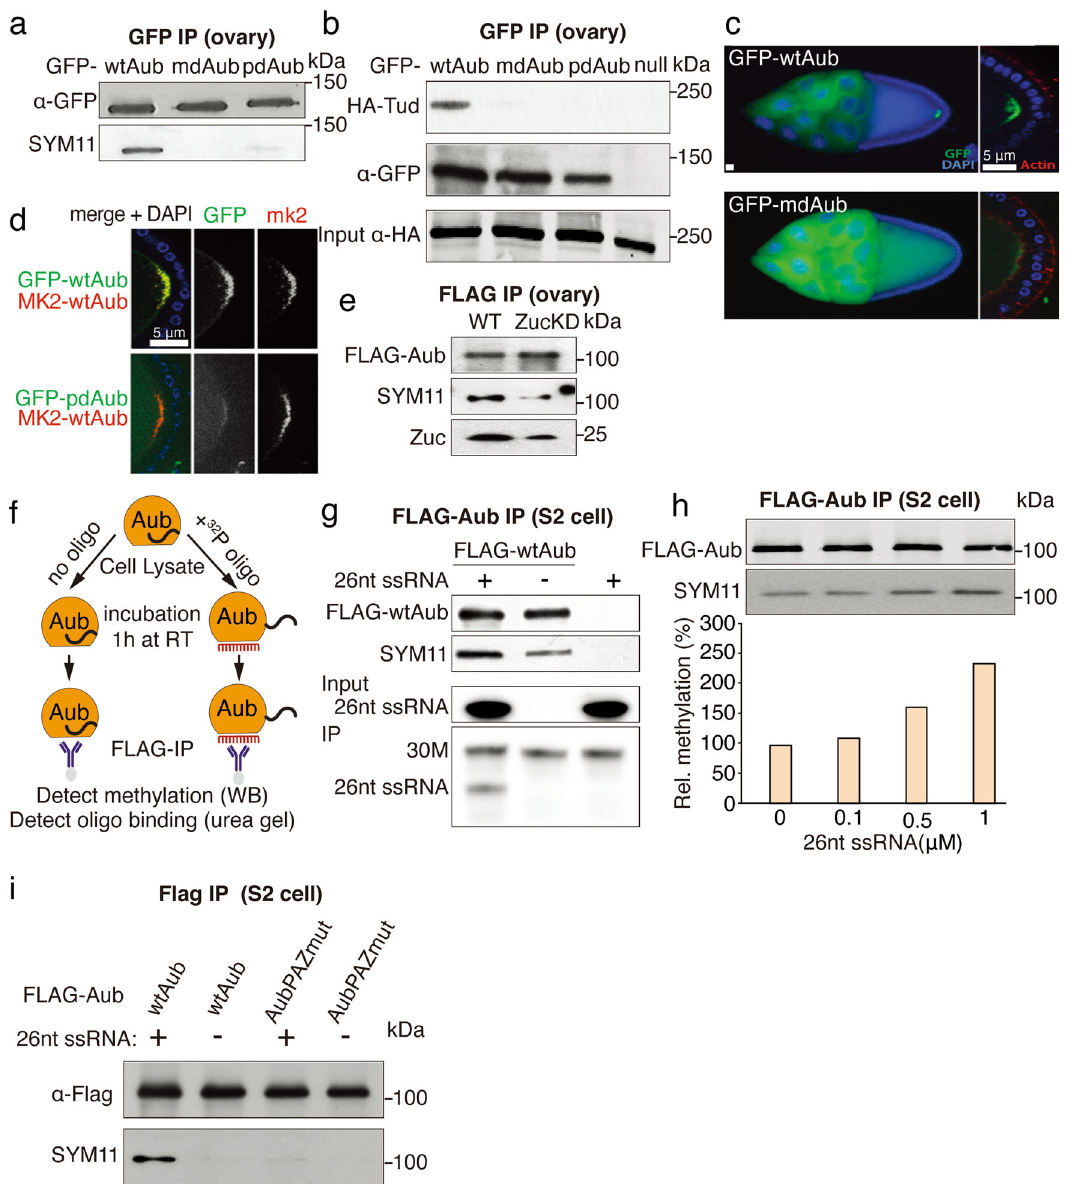
Fig. 5 RNA binding promotes Aub arginine methylation. a RNA binding is required for Aub arginine methylation in vivo. Transgenes were expressed on the wildtype background. Total protein level and methylation was detected in Western blot. The experiment reproduced three times with similar results. b RNA binding is required for Aub interaction with Tudor in vivo. GFP tagged Aub was immunoprecipitated from ovarian lysate, followed by Western blot detection of the tagged transgenes. Experiment reproduced twice with similar results. c Arginine methylation is required for the localization of Aub to the pole plasm. GFP tagged wtAub and mdAub were separately expressed in ovaries on the wild-type Aub background. Scale bar: 5 μ m. Ten independent ovaries were used for imaging with similar results. d RNA binding is required for Aub localization into the pole plasm. Upper panel: GFP-wtAub and mKate2-wtAub were co-expressed in ovaries in the wild-type Aub background. Bottom panel: GFP-pdAub and mKate2-wtAub were co-expressed in ovaries in the wild-type Aub background. Scale bar: 5 μ m. Ten independent ovaries were used for imaging with similar results. e Zucchini KD leads to decreased Aub arginine methylation. FLAG-tagged wtAub was immunoprecipitated from control and Zuc KD ovaries. Methylation was detected by Western blot. Experiment reproduced twice with similar results. f Scheme of in vitro oligo-binding experiments. Lysate of S2 cells expressing FLAG-Aub was incubated with or without 32 P labeled 26 nt RNA oligos followed by FLAG immunoprecipitation and detection of methylation by Western blot and oligo binding on urea gel. g RNA oligo binding promotes Aub sDMA modi fi cation. In total, 30 nt (30 M) ssRNA was spiked into each IP-ed sample to normalize for total IP-ed RNA amount. Experiment reproduced twice with similar results. h Aub methylation correlates with synthetic ssRNA concentration added to lysates of S2 cells expressing FLAG-Aub. Methylation was quanti fi ed based on band intensity in FLAG and SYM11 Western blot and normalized to the no oligo control. Experiment reproduced twice with similar results. i Binding of the RNA 3 ′ end by Aub ’ s PAZ domain is required for sDMA modi fi cation. Wild- type Aub and AubPAZmut were expressed in S2 cells. sDMA modi fi cation was detected by western blot using SYM11 antibody. Experiment reproduced twice with similar